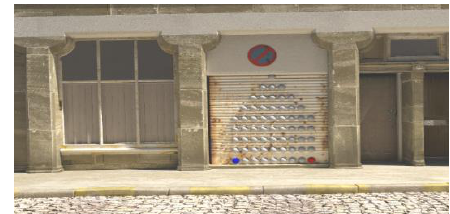
Figure 8. Incidence relation: Point-point-point. The trifocal tensor is composed by three matrices: T = (T 1 , T 2 , T 3 ) . It can be used to express the incidence relationship for the points of correspondence.